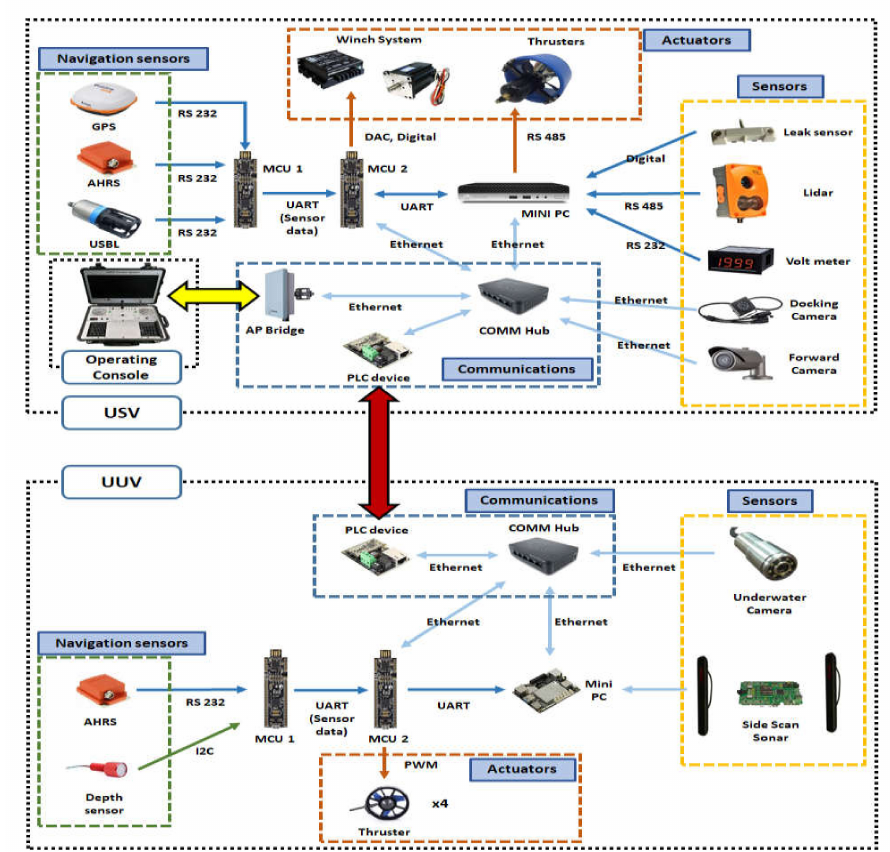
Figure 16. Diagram of the integrated platform control